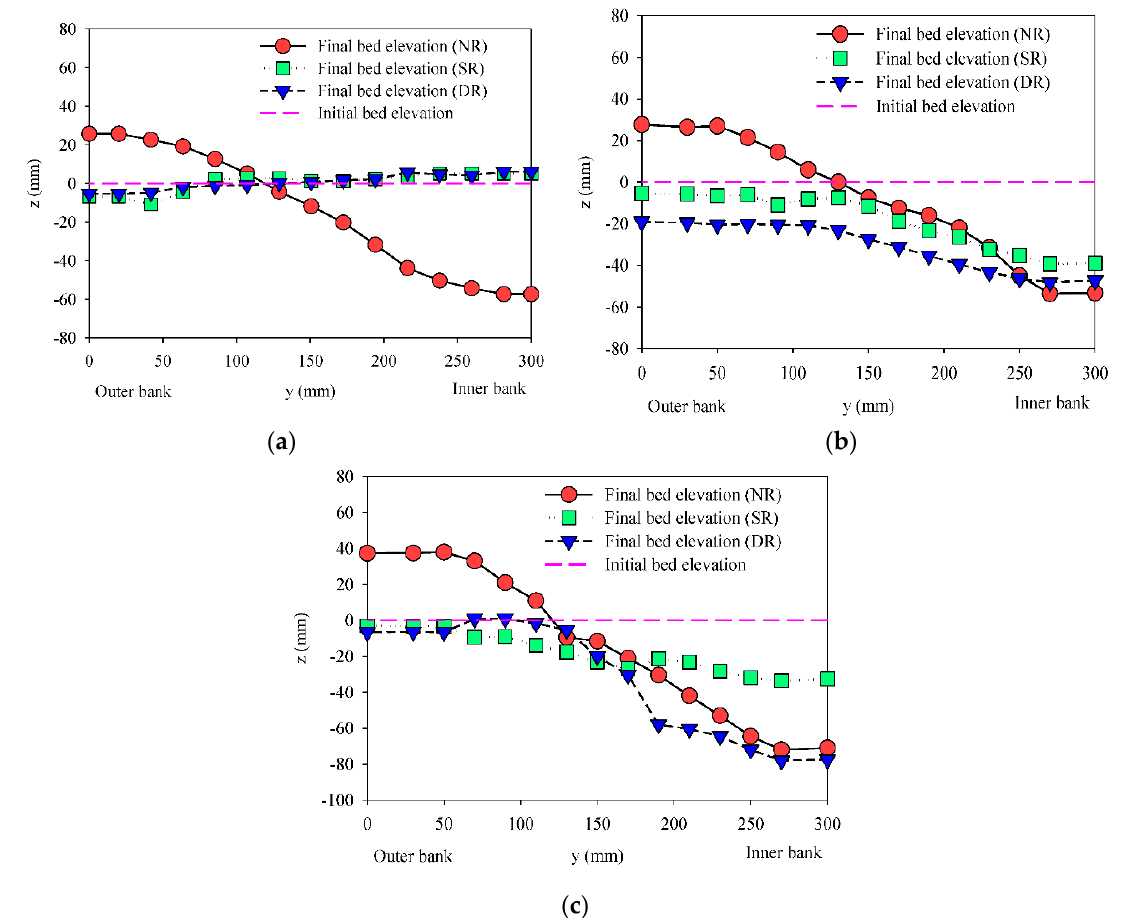
Figure 4. Bed elevations at the entrance of the test section (cross-section C1): ( a ) Q = 10, ( b ) Q = 15 and ( c ) Q = 20 L/s.